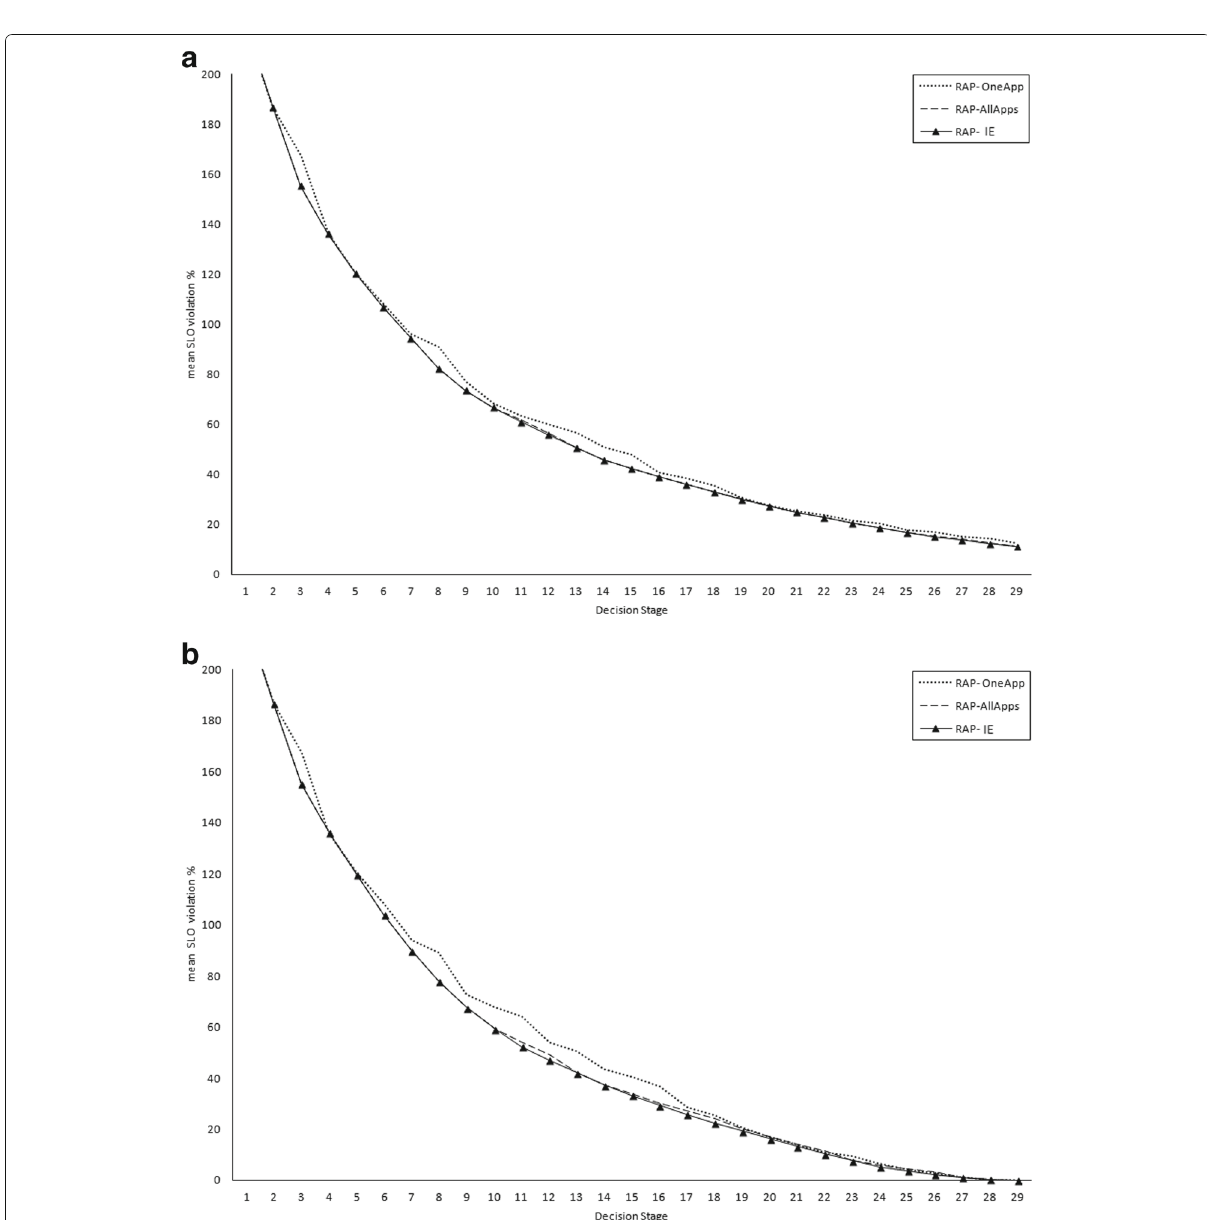
Fig. 7 Effect of Homogeneous and Heterogeneous scaling. a Bursty Arrivals - Homogeneous Scaling. b Bursty Arrivals - Heterogeneous